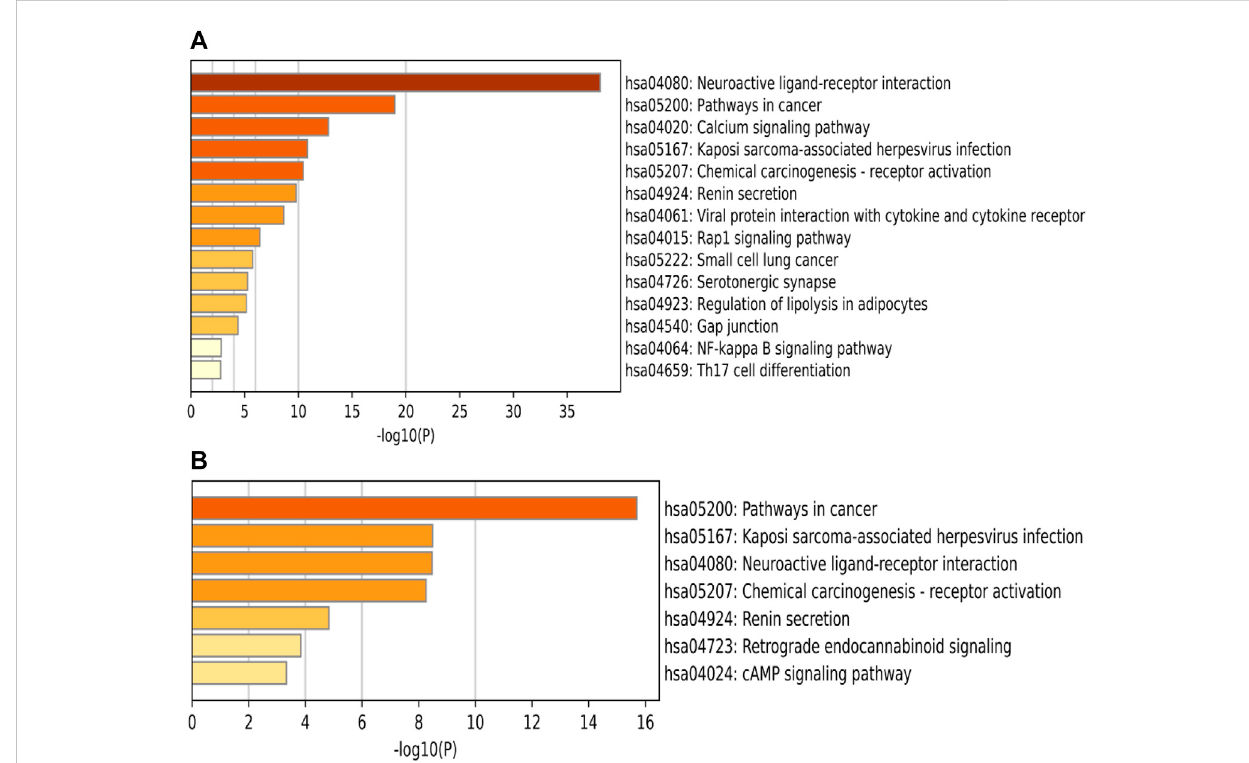
FIGURE 8 BargraphofKEGGenrichmentpathways. Thehorizontalcoordinatesrepresentthe p -valueswithlogbase10andtheverticalcoordinatesrepresent the pathway names. The color represents theenrichment signi fi cance, thedarker the color, thehigher theenrichment. Figure (A) show KEGG PATHWAY information via intersecting targets, Figure (B) show KEGG PATHWAY information via key targets.